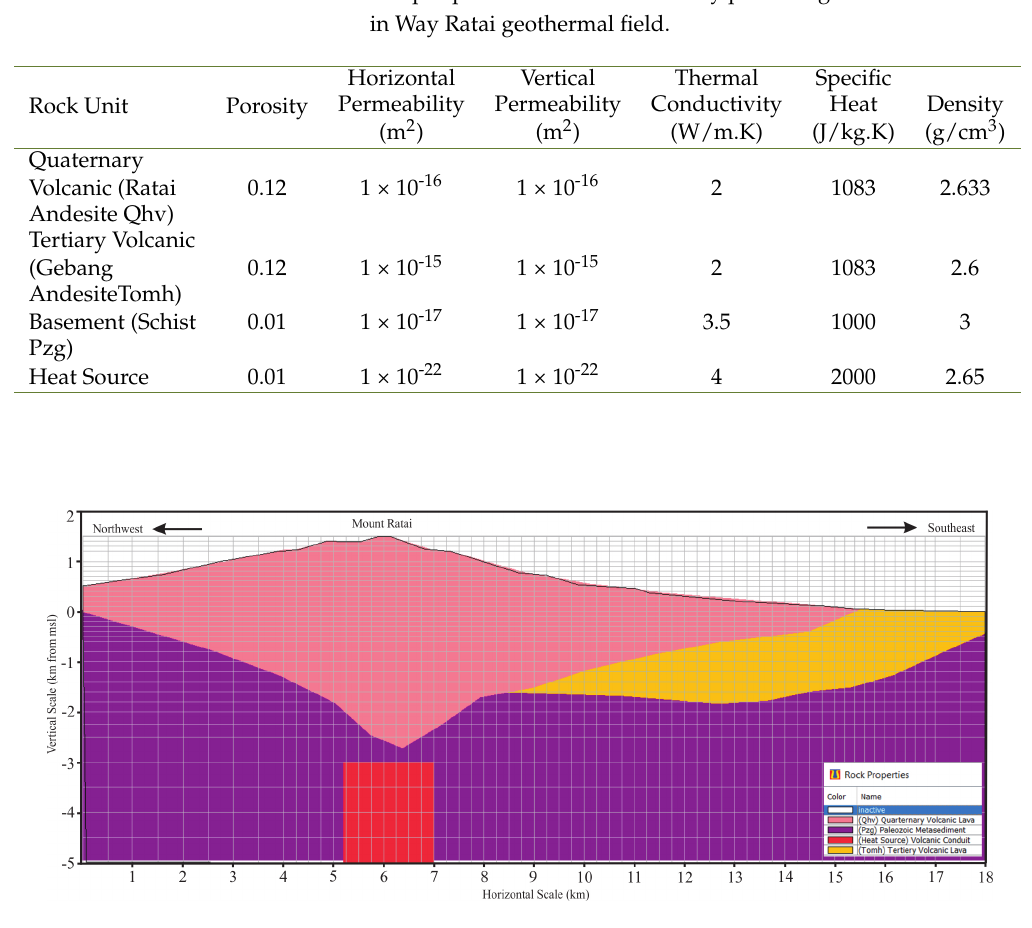
Fig. 3. Geological profile model simplified in Way Ratai from numerical